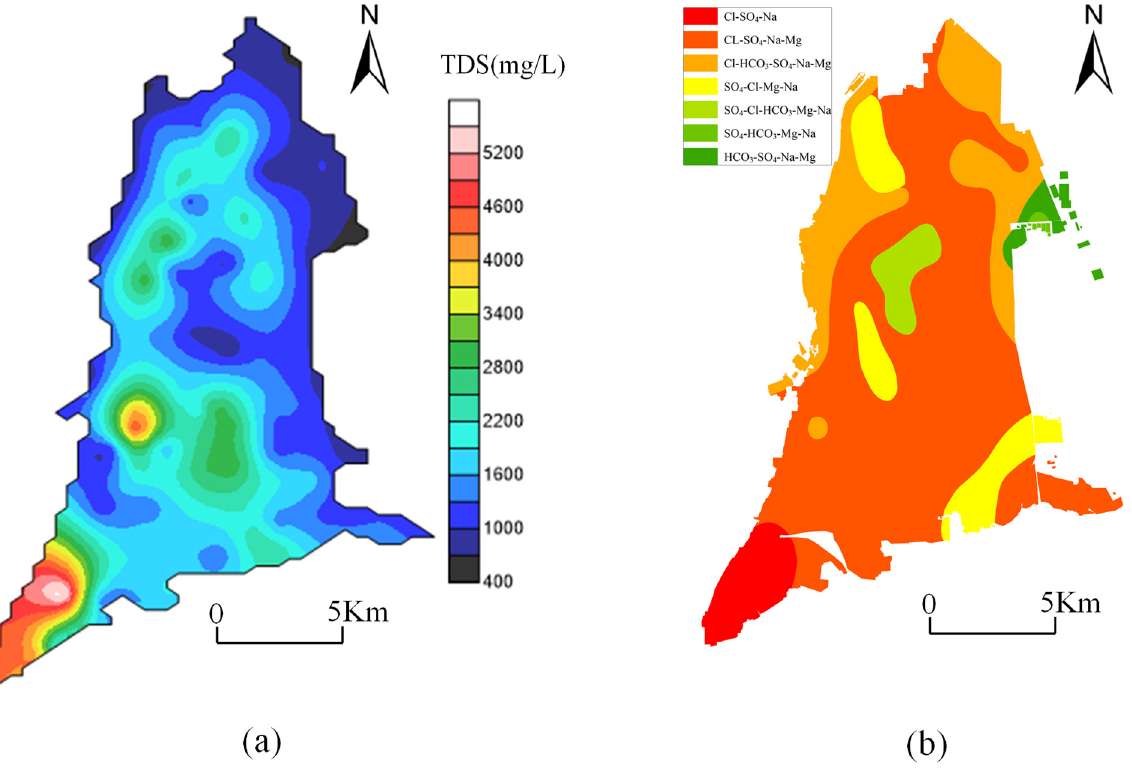
Figure 6. Spatial Distribution of TDS and hydrochemical water type. ( a ) TDS; ( b ) hydrochemical type.